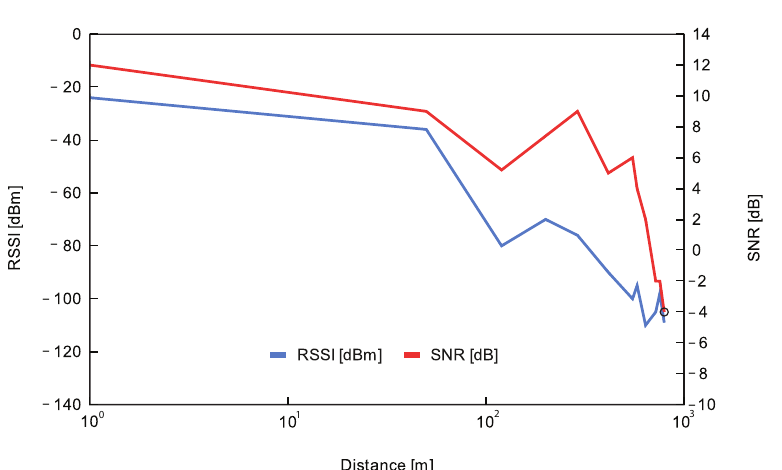
Figure 5. LoRa communication values in outdoor testing: Average RSSI [dBm] and Average SNR [dB] as a function of distance